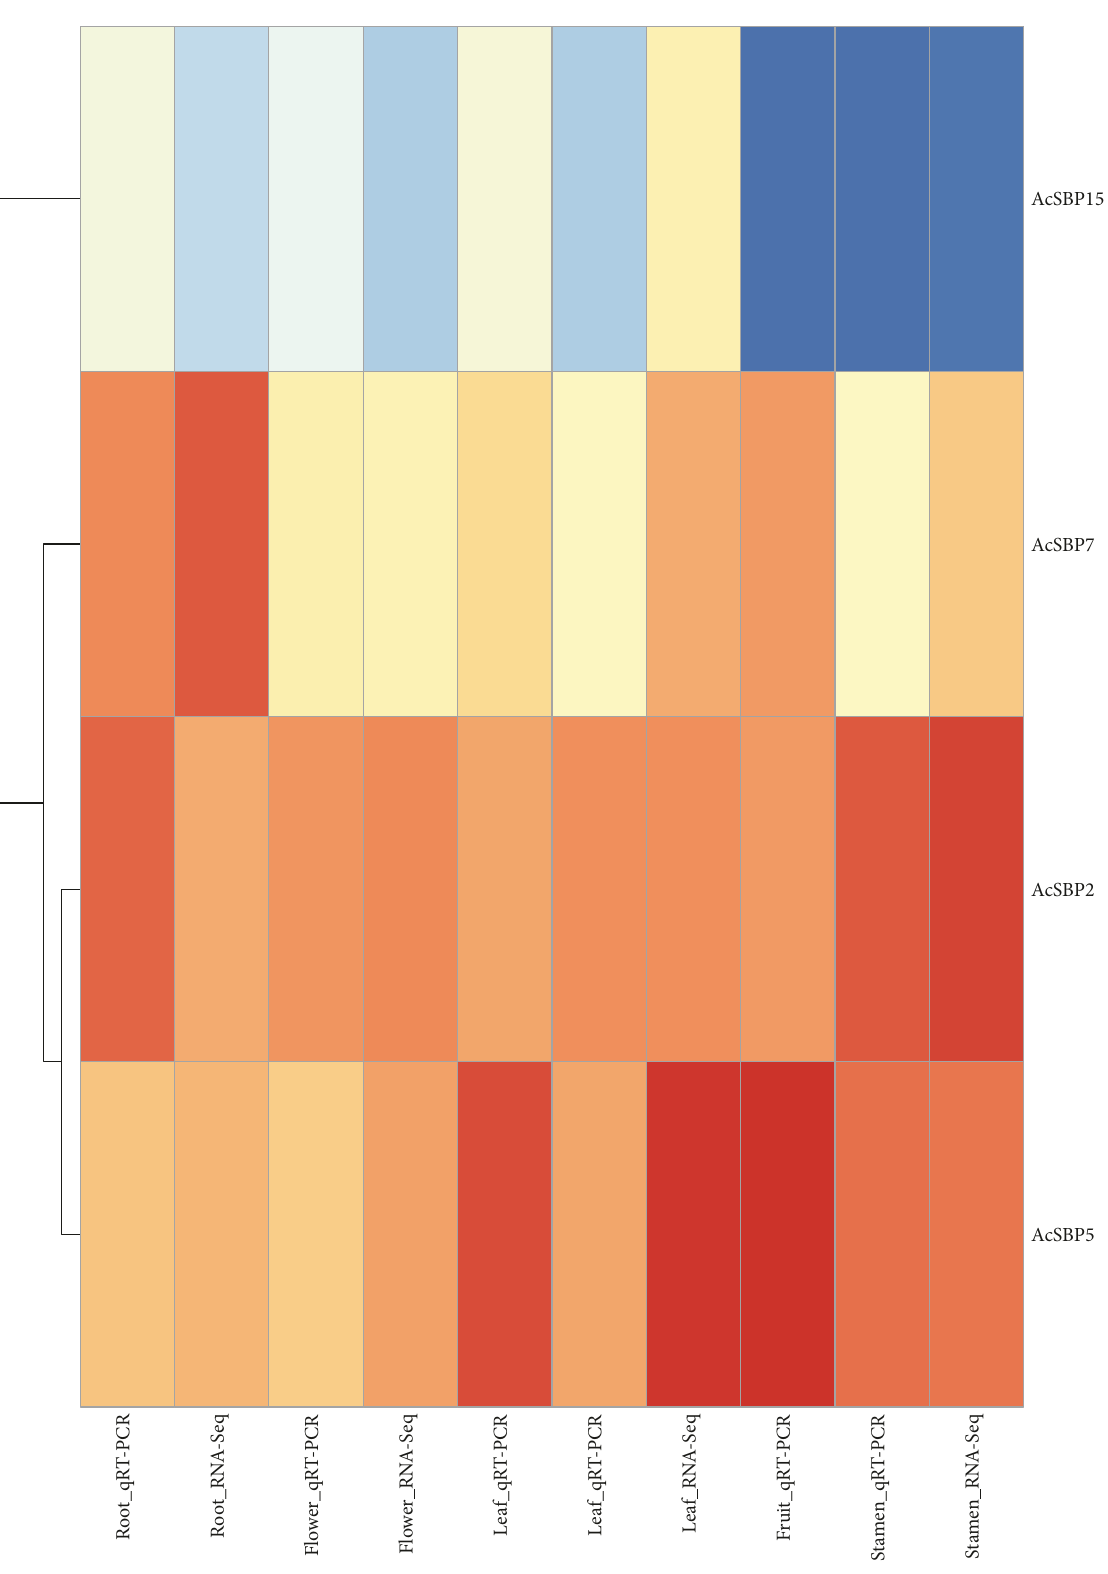
Figure 5: A heat map of validation of RNA-Seq of four SBP genes through qRT-PCR. The heat map was constructed using relative expression of four genes in fi ve di ff erent tissues tested by qRT-PCR along with FPKM values of RNA-Seq of these